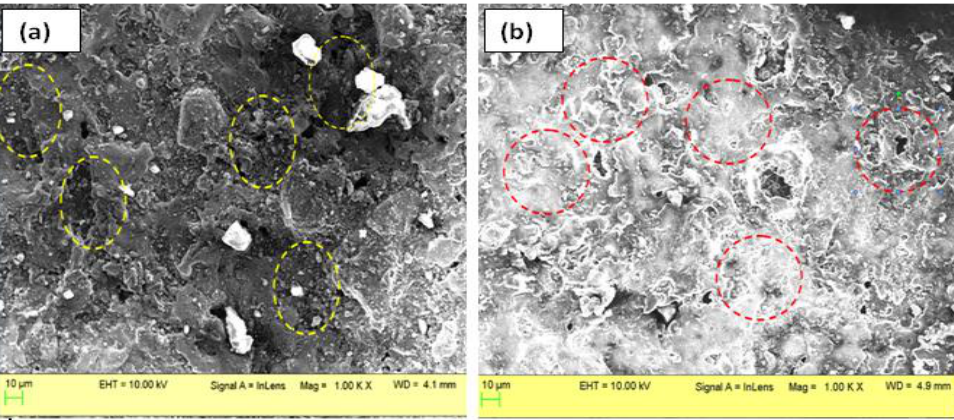
Figure 5. Scanning electron microscope (SEM) analysis of workpiece after machining ( a ) Al-37% SiC shows ablation mechanism of material removal; ( b ) Al-63% SiC shows melting as the dominating material removal mechanism.